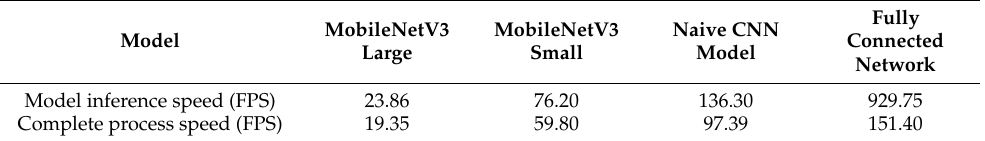
Table 5. Inference speed of the model on OrangePi 3 LTS.